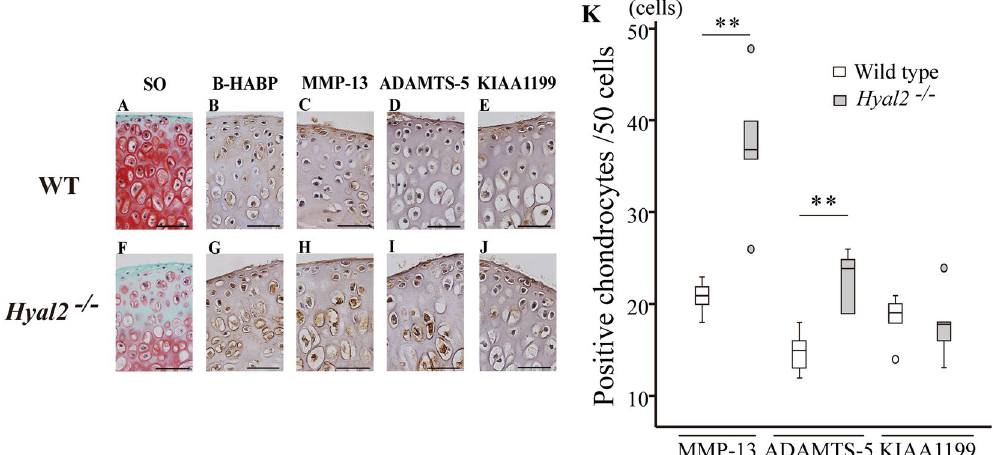
Figure 7. Articular cartilage explant culture with IL-1 α of WT and Hyal2 − / − mice. Pieces of articular cartilage was cultured for 72 h in serum free DMEM containing 10 ng/ml mouse IL-1 α , and were subjected to Safranin O staining (SO) (A; WT, F; Hyal2 − / − ), B-HABP staining (B; WT, G; Hyal2 − / − ), MMP-13 staining (C; WT, H; Hyal2 − / − ), ADAMTS-5 staining (D; WT, I; Hyal2 − / − ), and KIAA1199 staining (E; WT, J; Hyal2 − / − ). The numbers of positive stainable cells were graphed ( ** = P < 0.01) (K). Small circle represented